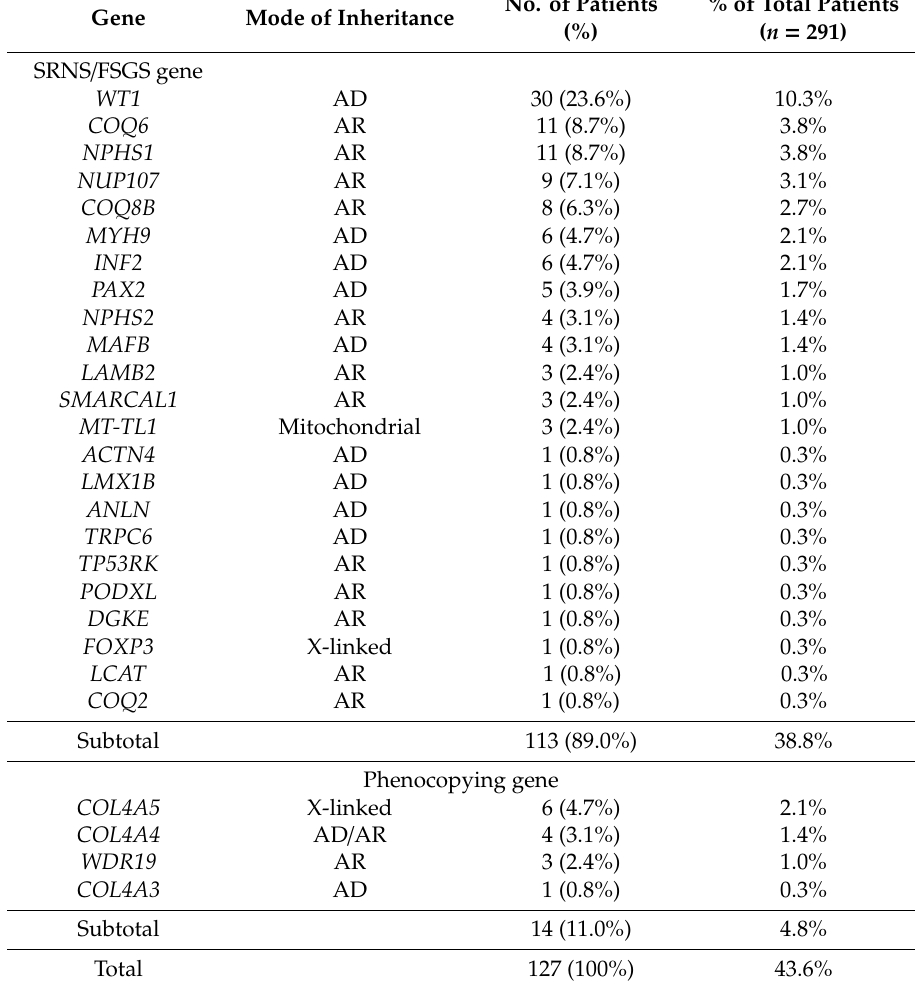
Table 2. Mutation screening